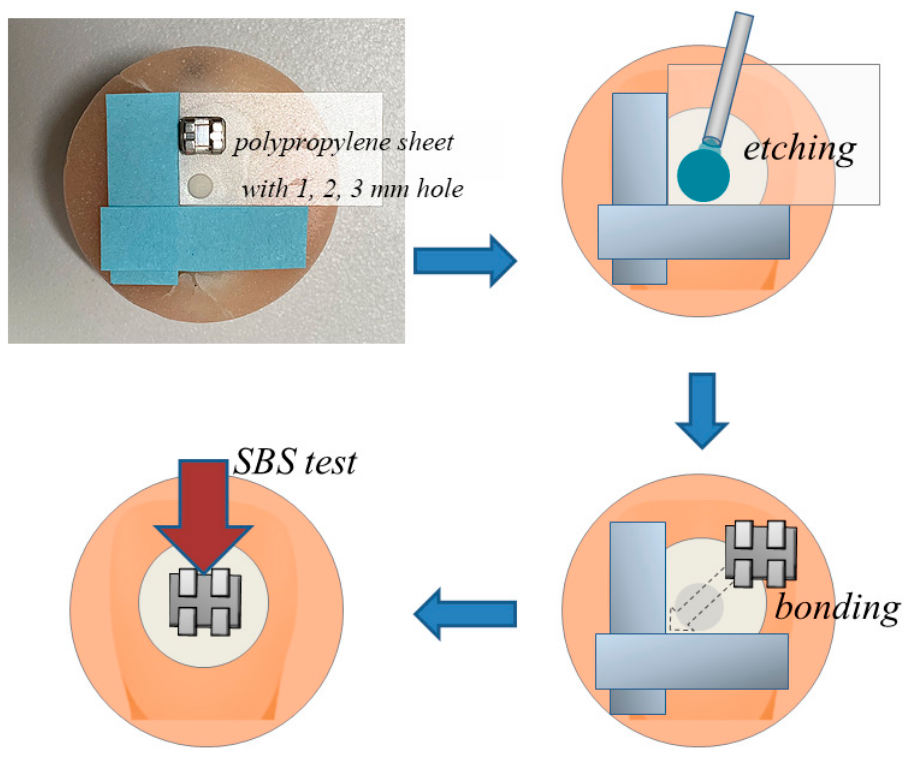
Figure 1. Bonding